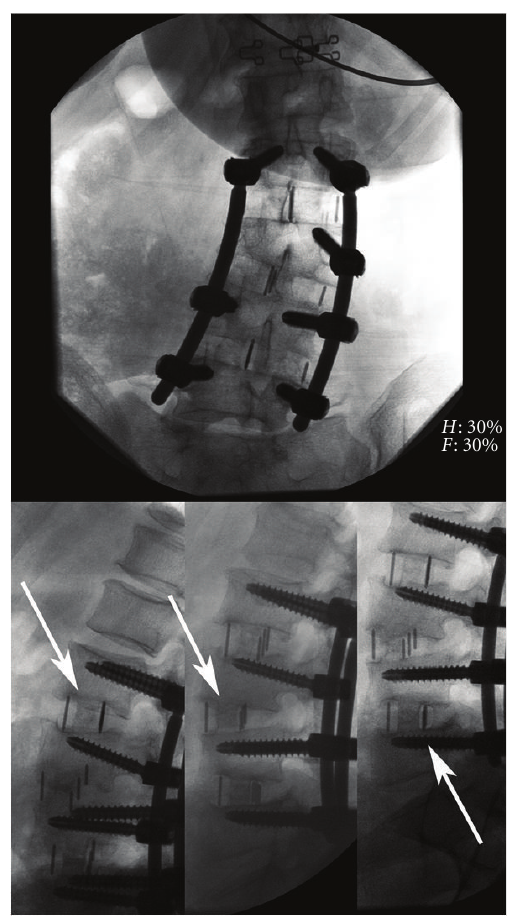
Figure 1: Anterior and lateral fluoroscopy-guided, level-by-level radiography. Note that parallel endplates were obtained on lateral radiography using this technique (white arrows), avoiding X-ray